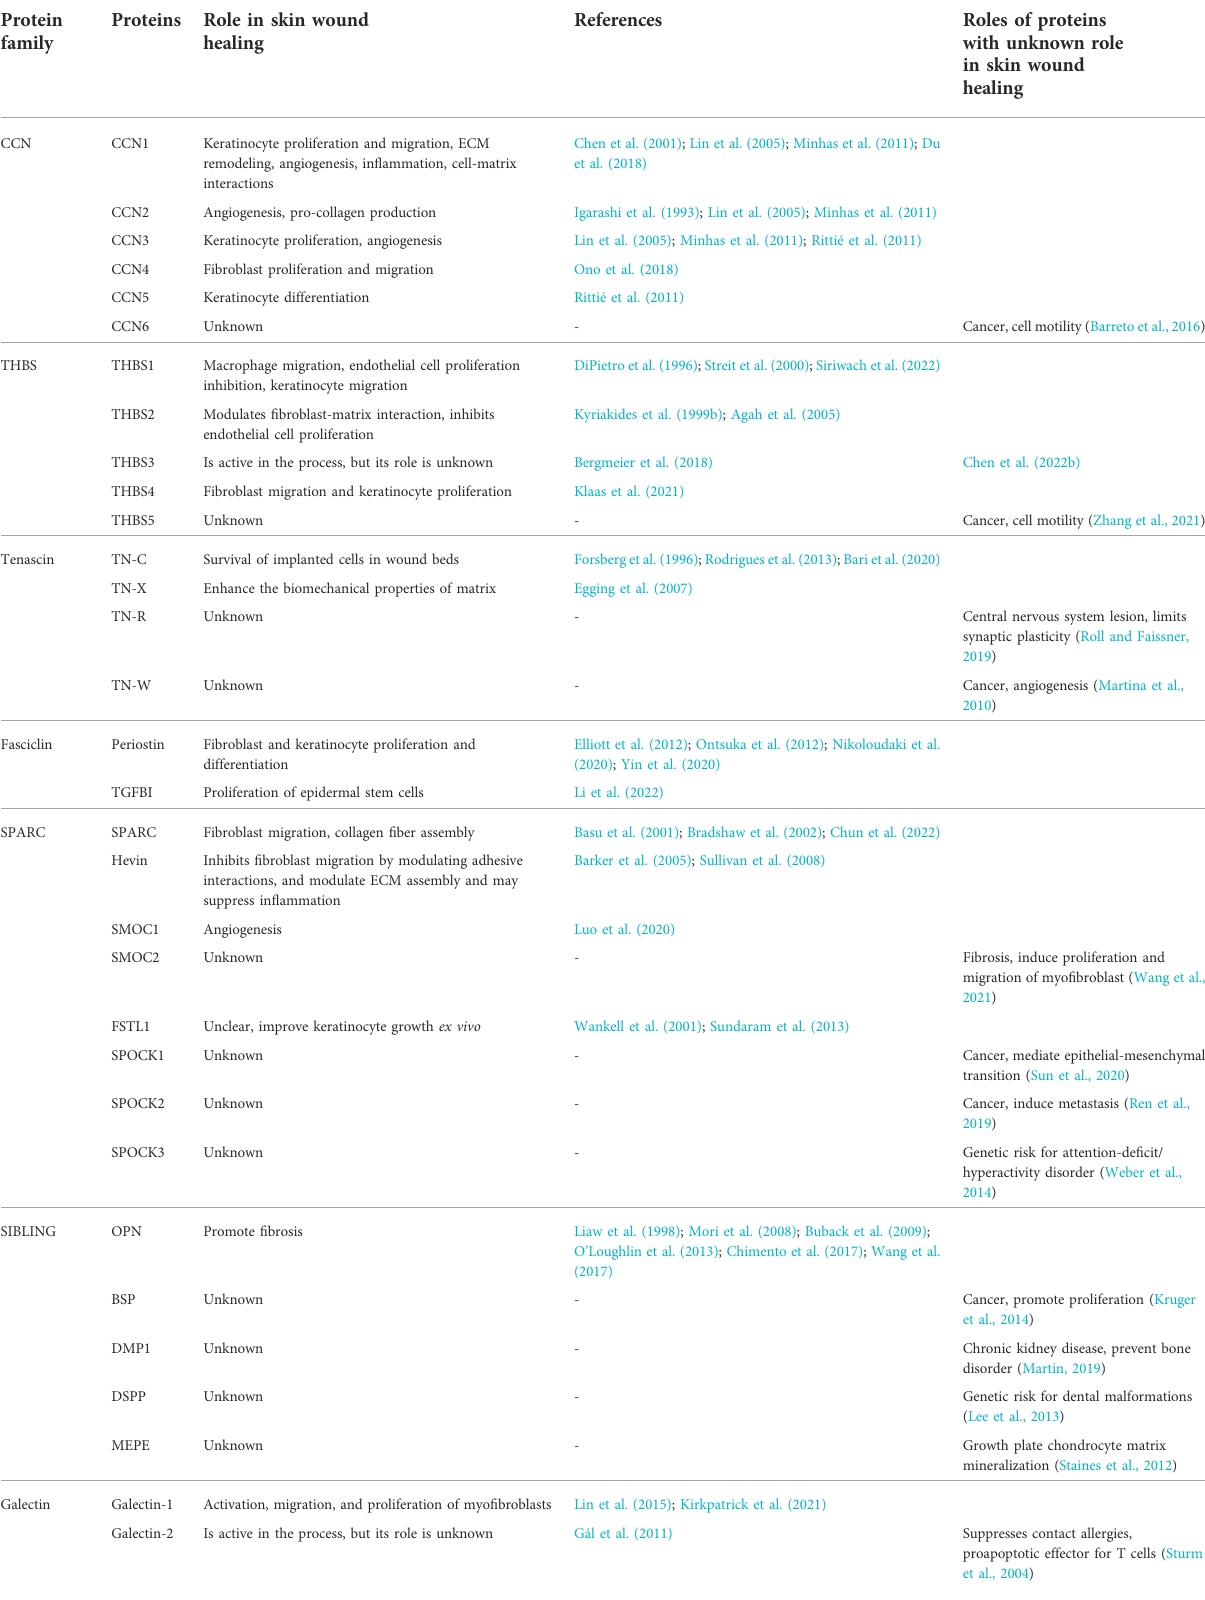
TABLE 1 Matricellular proteins classi fi ed by the protein family. Role in wound healing is shown, if known. For proteins with an unknown role in skin wound healing, at least one promoting/inducing function is listed, unless otherwise noted. Protein